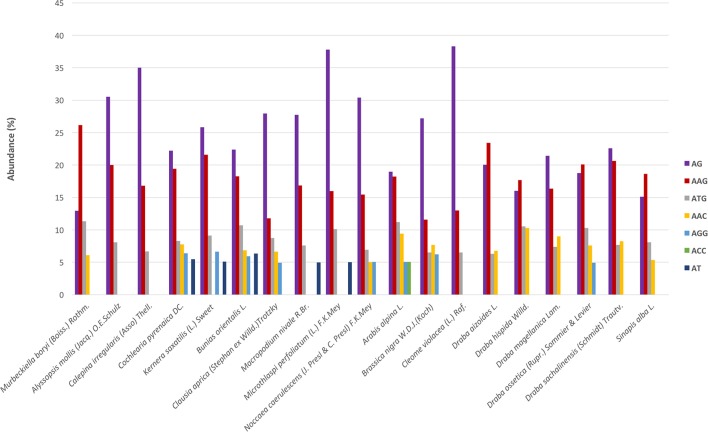
SSR's motifs distribution across species. The x-axis indicates species and the y-axis abundance in percentage. Each motif is denoted by a color as shown in the legend. Bars represents those motifs with ≥5% abundance. These motifs represent, depending on the species, between 55 and 75% of the total motifs' frequency.